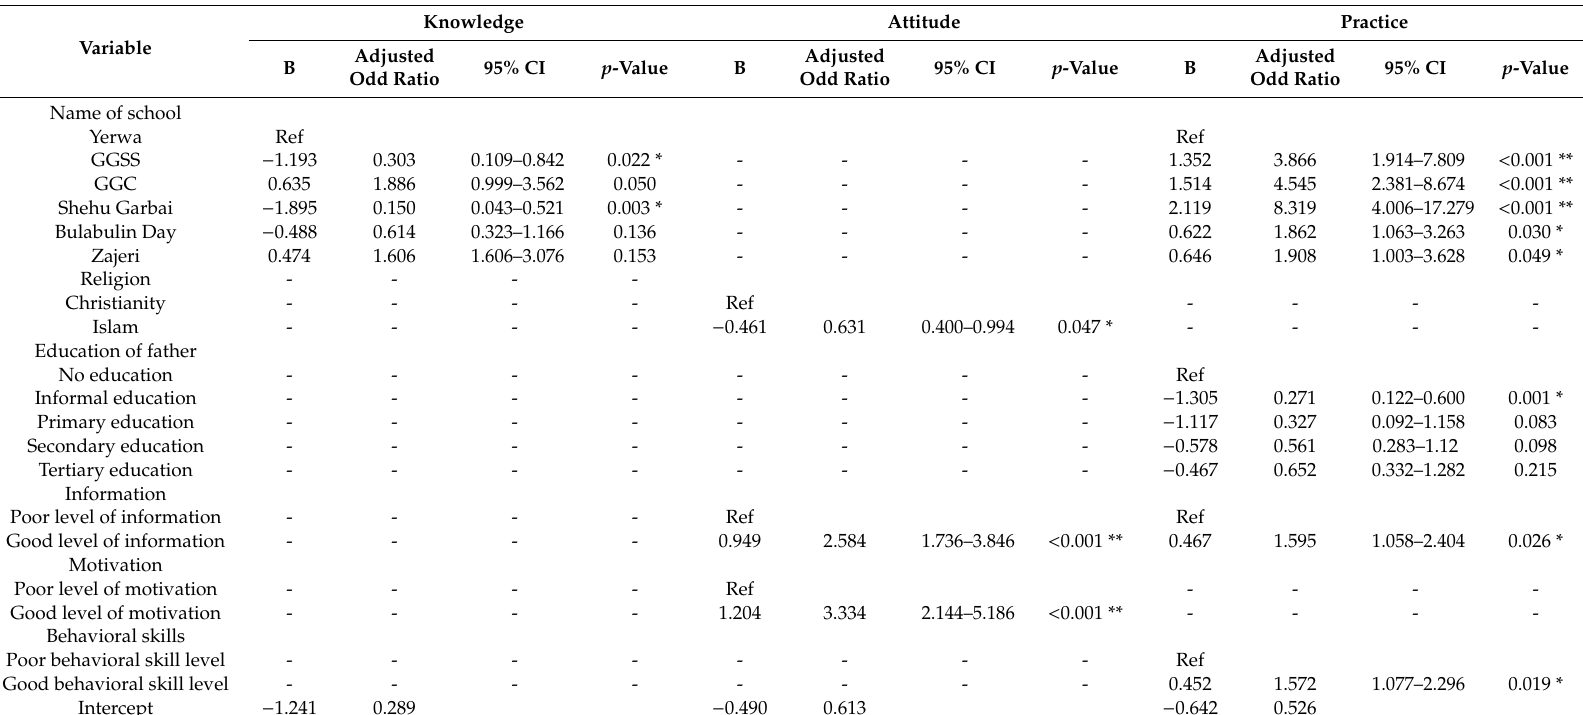
Table 6. Multivariable logistic regression model predicting the knowledge, attitude, and practice of adolescent girls towards reducing malnutrition.